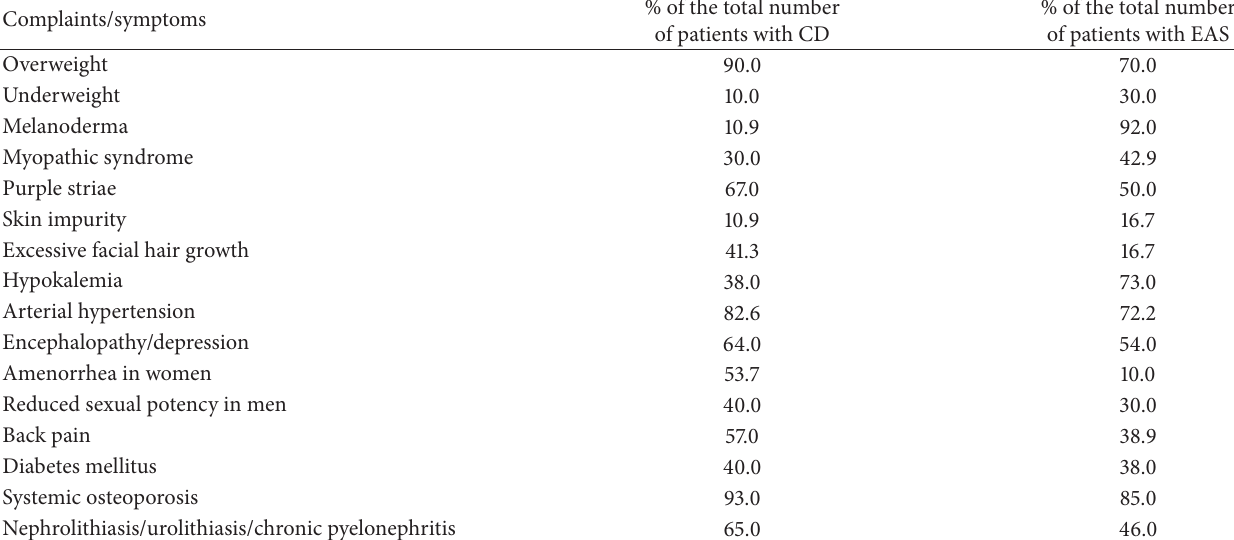
Table 1: Frequency of main symptoms and complaints in patients with CD and